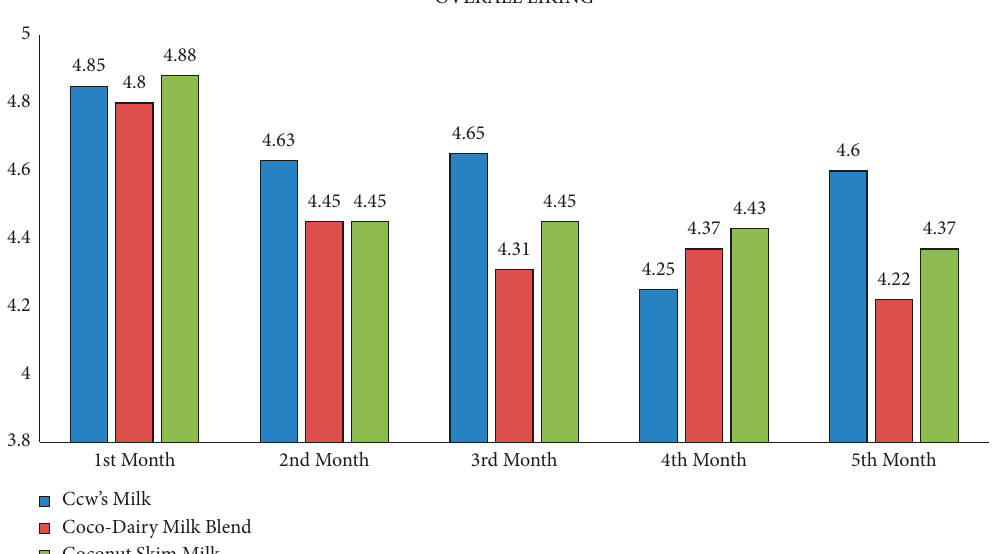
Figure 4: Average acceptability scores of milk products according to overall liking by